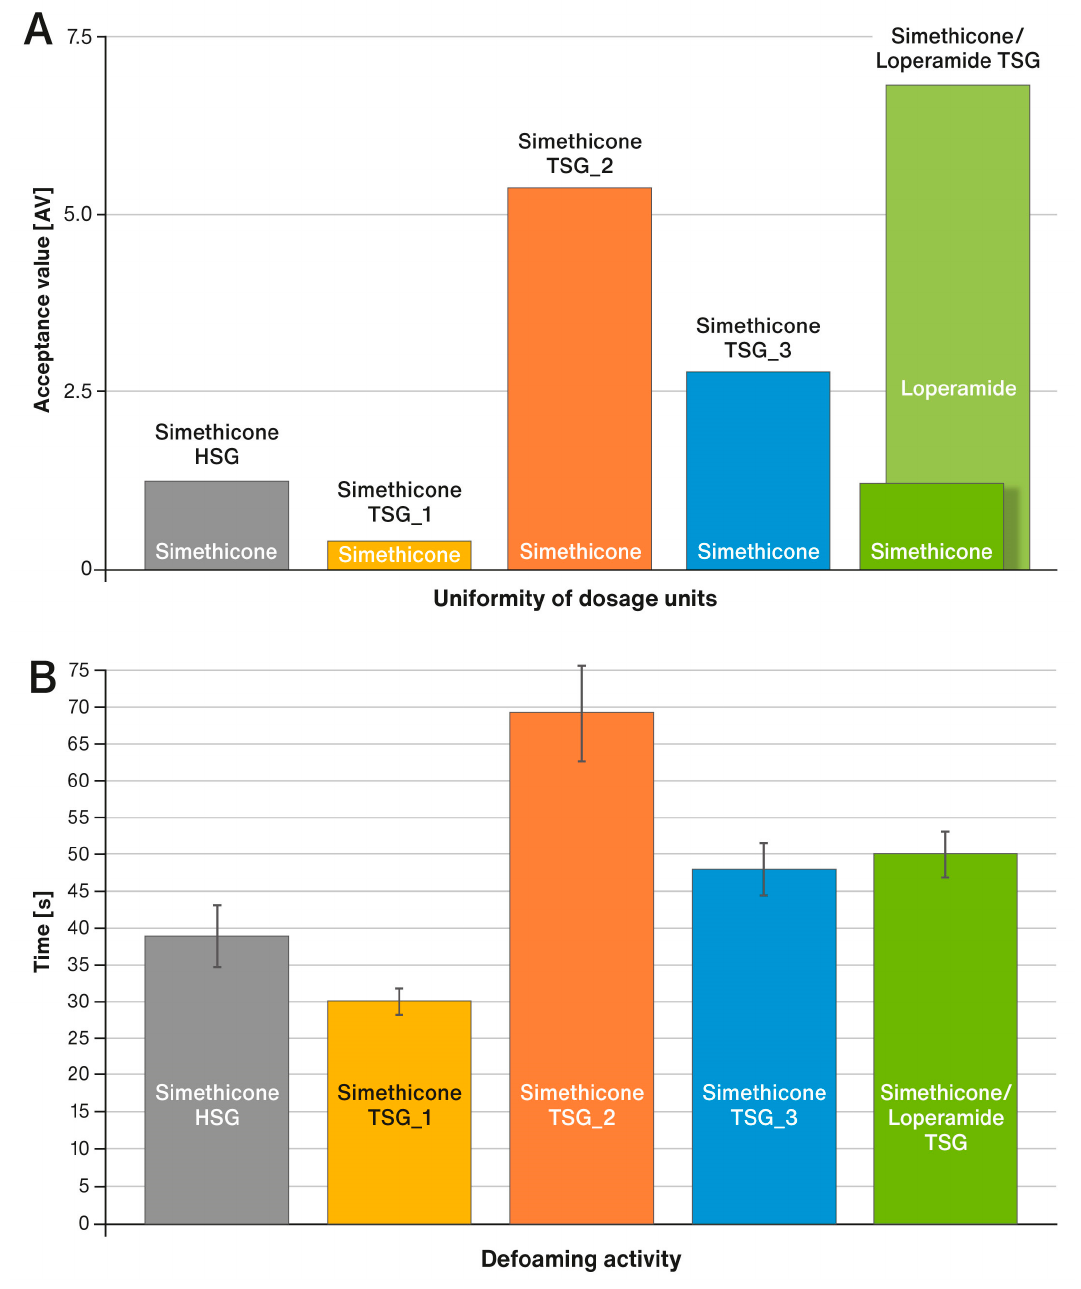
Figure 6. ( A ) Uniformity of dosage units and ( B ) Defoaming activity of liquisolid tablets compressed at 20 kN; means of n = 6. SD is indicated by the error bars.